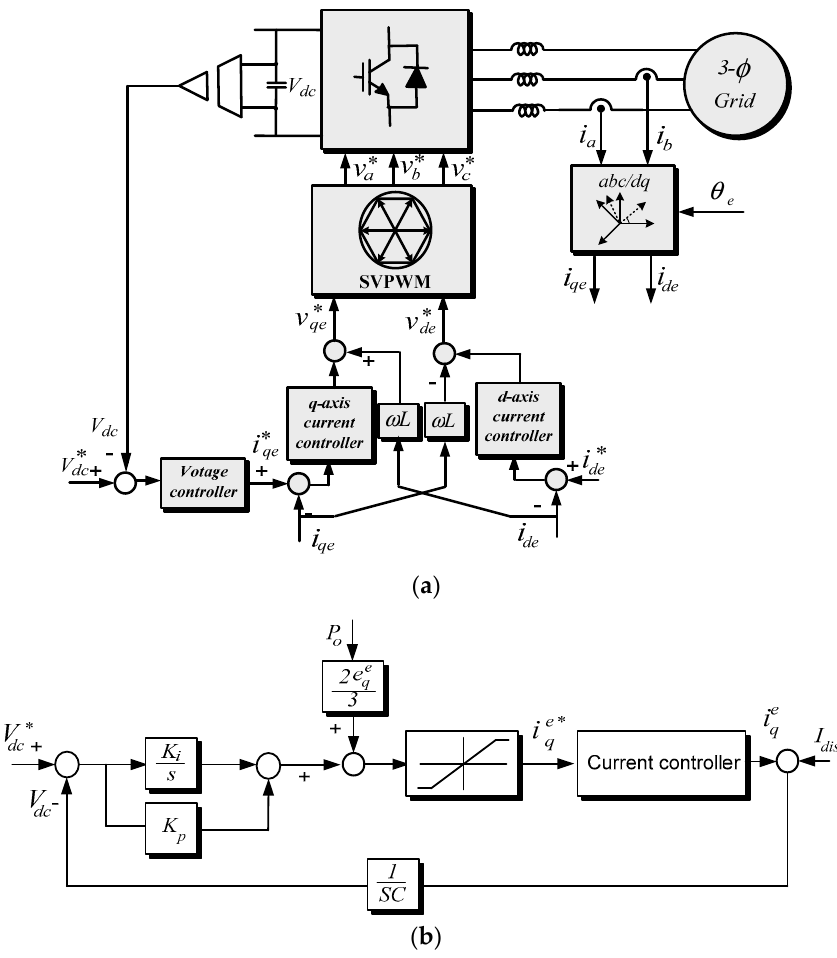
Figure 12. ( a ) DFIG grid-side control, ( b ) voltage controller block diagram.